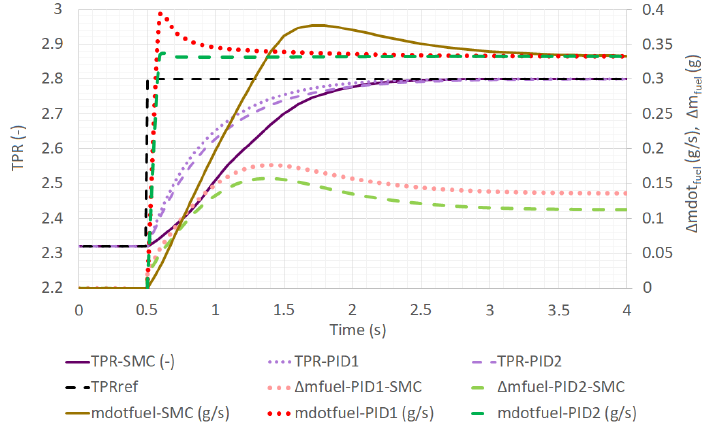
Figure 8. Comparison of time series of SMC and two different PID